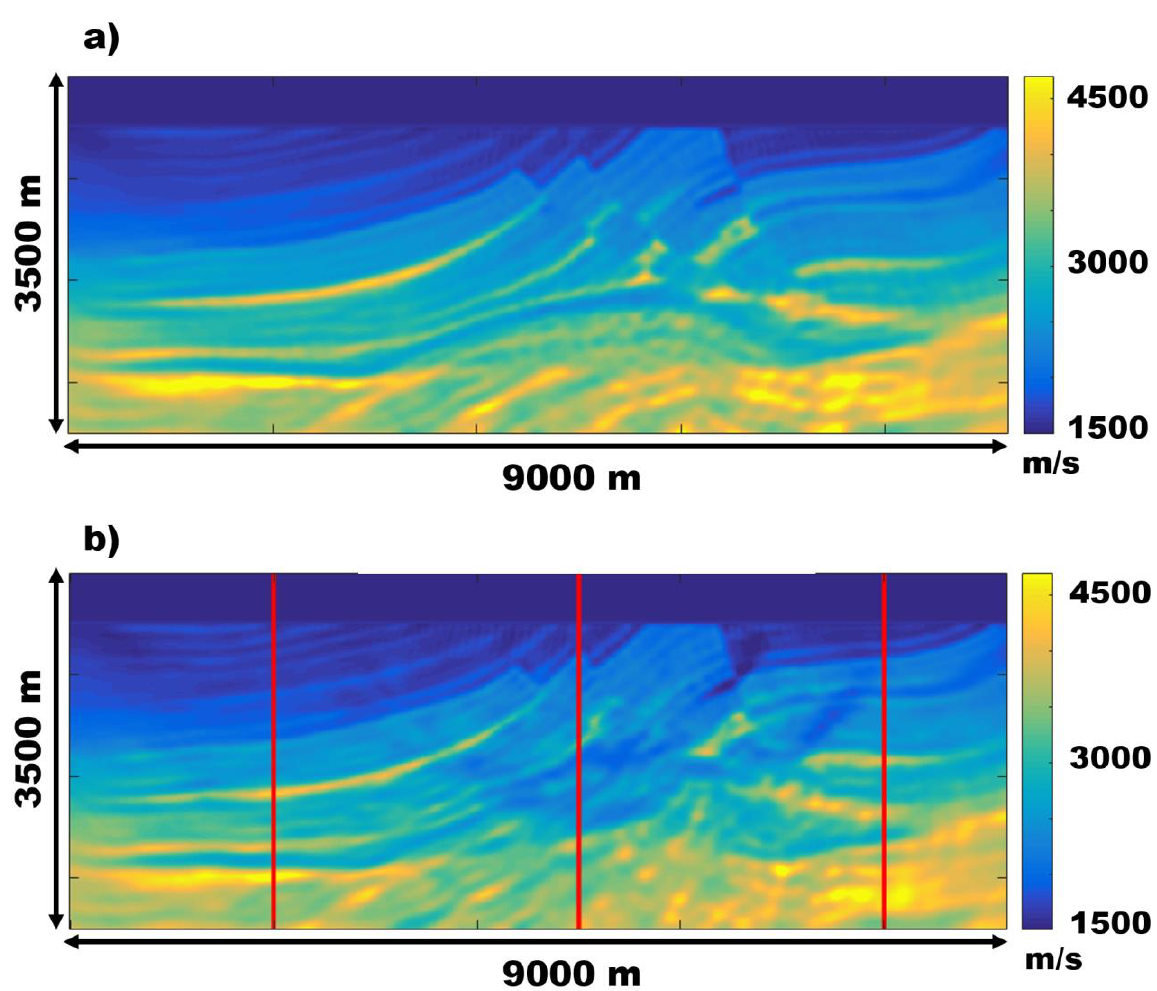
Figure 8. ( a ) The result of the classic FWI for frequencies {5,7,10} Hz. ( b ) The results of developed asymptotic full waveform inversion method for frequencies {5,7,10} Hz.